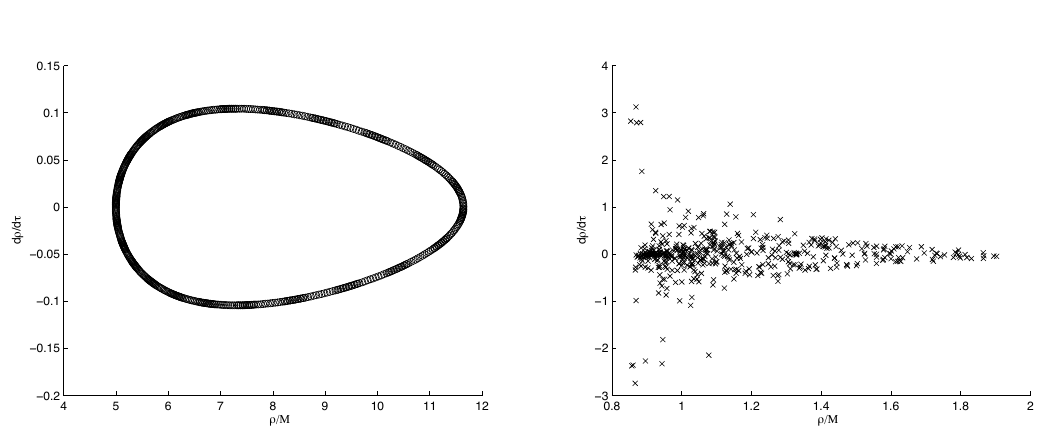
Figure 7: Poincar´e map for a regular orbit (left panel) and a chaotic orbit (right panel) in the Manko– Novikov spacetime. Image reproduced by permission from [195], copyright by